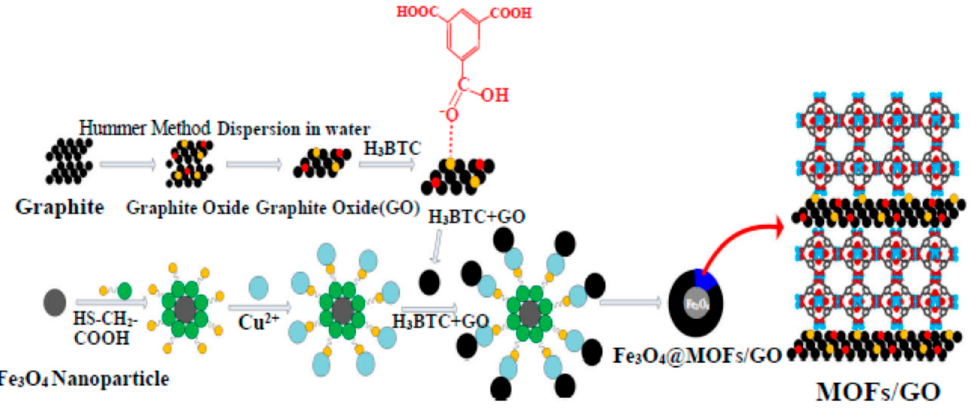
Figure 3. Illustration of the fabrication of Fe 3 O 4 @MOFs/GO microspheres [79]. MOFs: metal-organic frameworks; GO: graphene oxide.